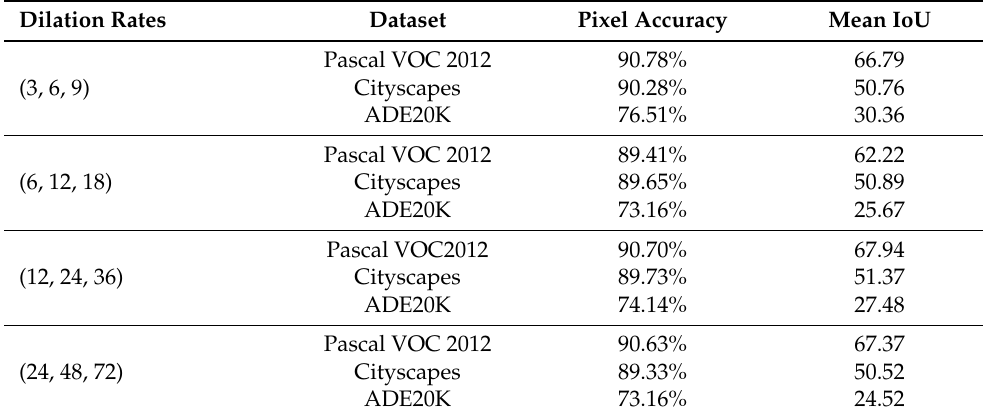
Table 14. Results obtained by adding an atrous spatial pyramid pooling (ASPP) module to the proposed model, between the middle flow and the upsampling flow.